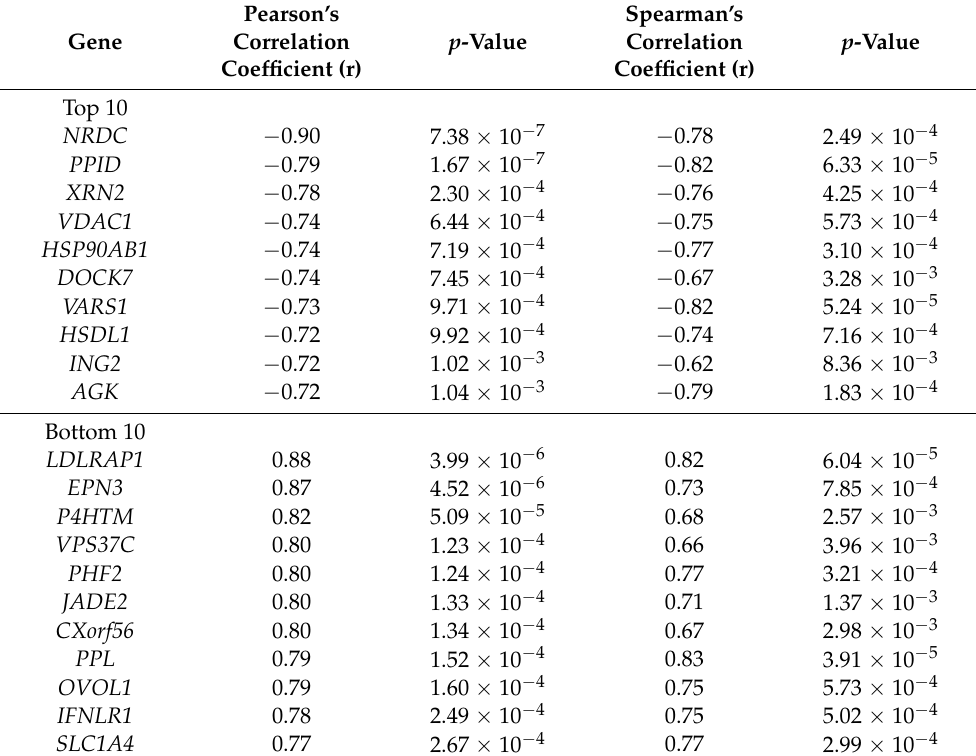
Table 1. Candidate genes that predict the response to simvastatin according to Pearson’s product- moment correlation coefficient